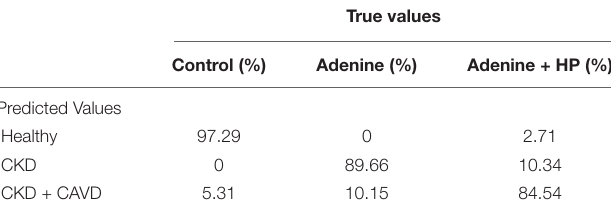
Confusion matrix for algorithm developed to classify S2